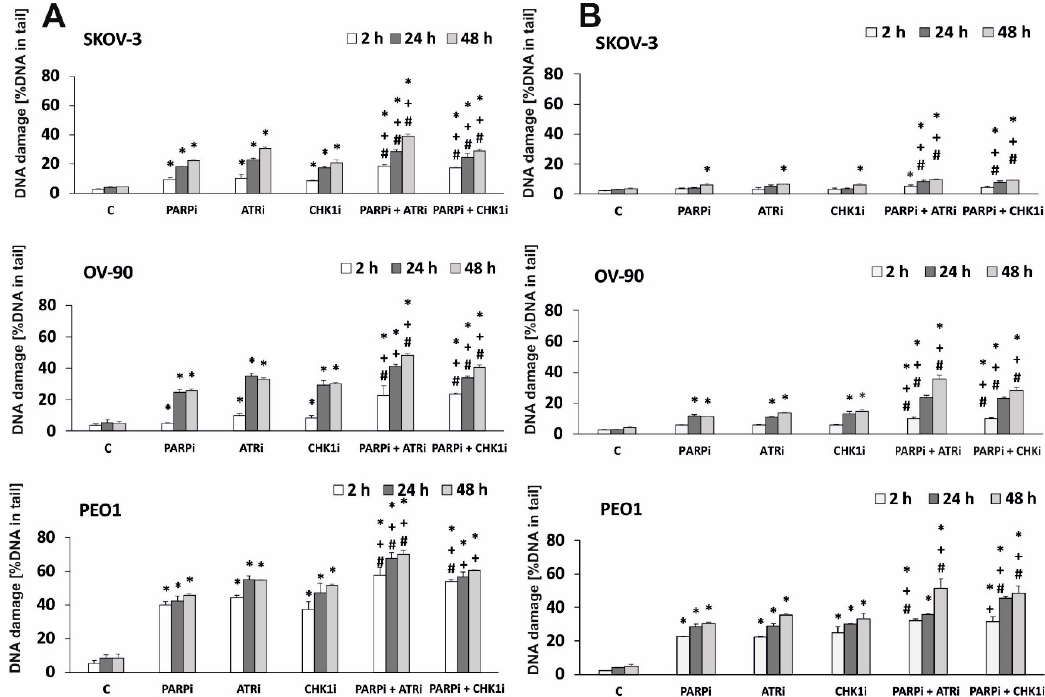
Figure 3. CHK1i and ATRi have a synergistic effect with PARPi on inducing DNA damage. The level of DNA damage in EOC cell lines treated with PARPi, ATRi, and CHK1i alone and in combination, measured as a percentage of the DNA in the comet tail. ( A ) The alkaline version, ( B ) the neutral version of the comet assay. Samples were treated for 2, 24, and 48 h. Error bars denote SD, * indicates statistically significant differences between the samples incubated with the drugs compared with control cells ( p < 0.05). + Statistically significant differences between samples incubated with PARPi and combination treatment (PARPi/ATRi; PARPi/CHK1i) ( p < 0.05). # Statistically significant differences between the samples incubated with ATRi or CHKi and combination treatment (PARPi/ATRi; PARPi/CHK1i) ( p < 0.05). Statistical analysis was performed using the ANOVA test with the Tukey’s post-hoc test for multiple